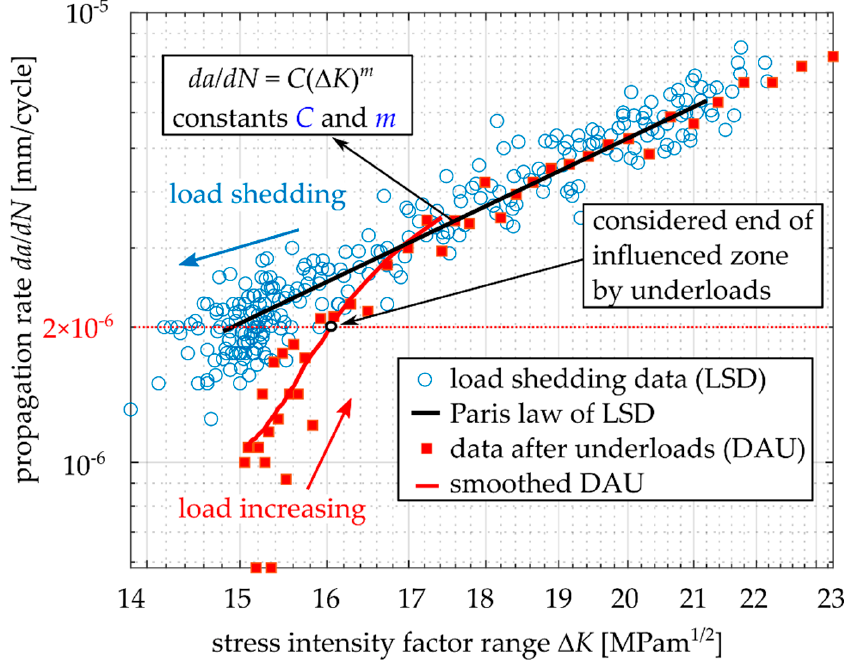
Figure 9. Demonstration of different crack propagation rates before and after application of underload cycles.